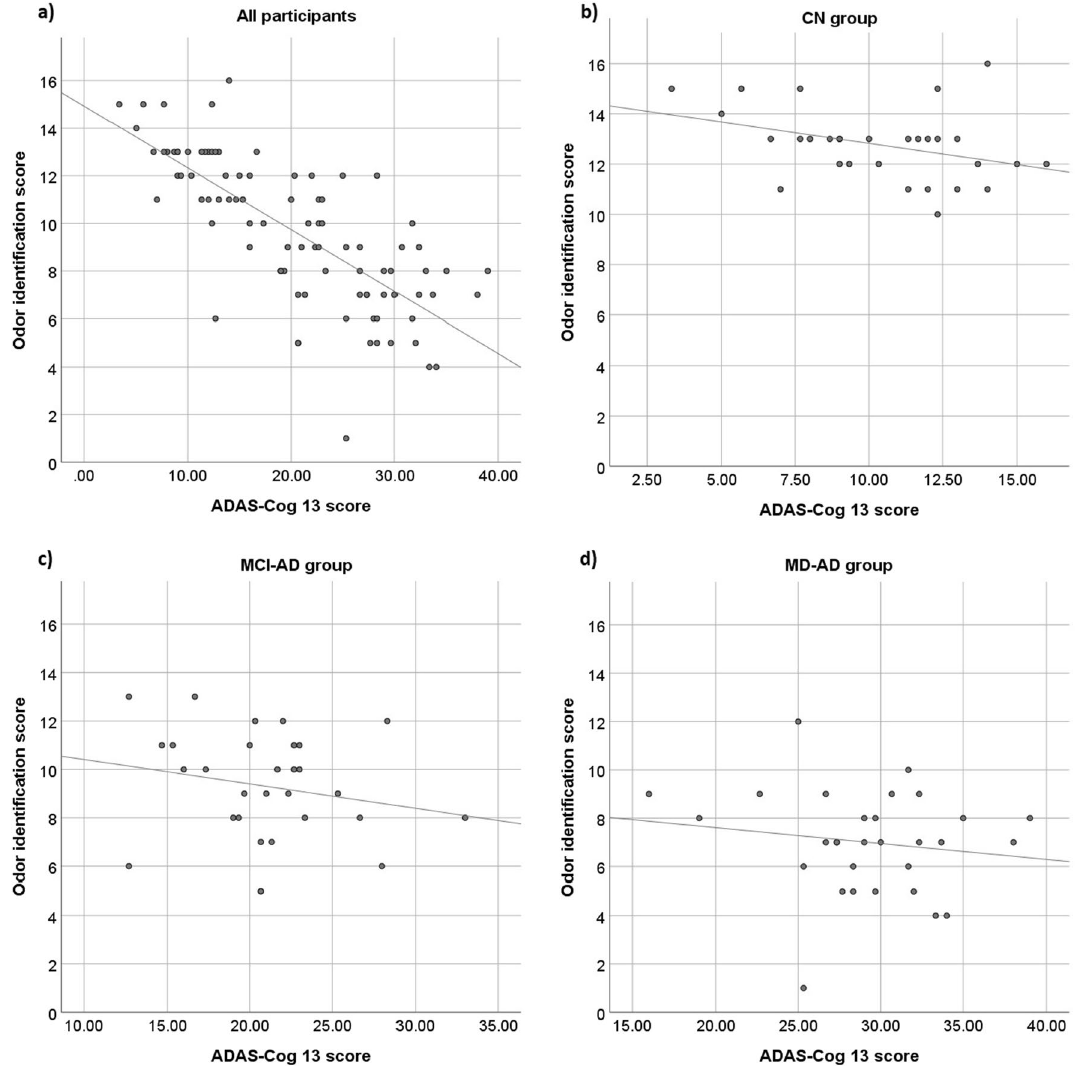
Figure 2. Relationship between odor identification scores and ADAS-Cog 13